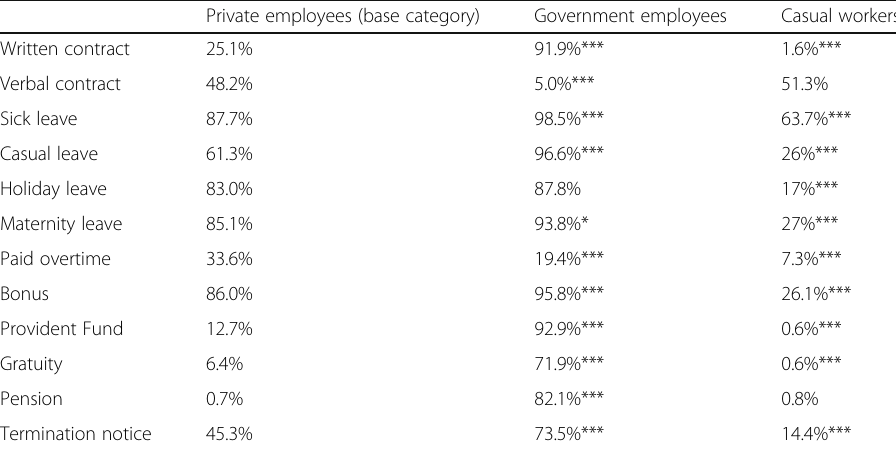
Table 4 Benefits by type of